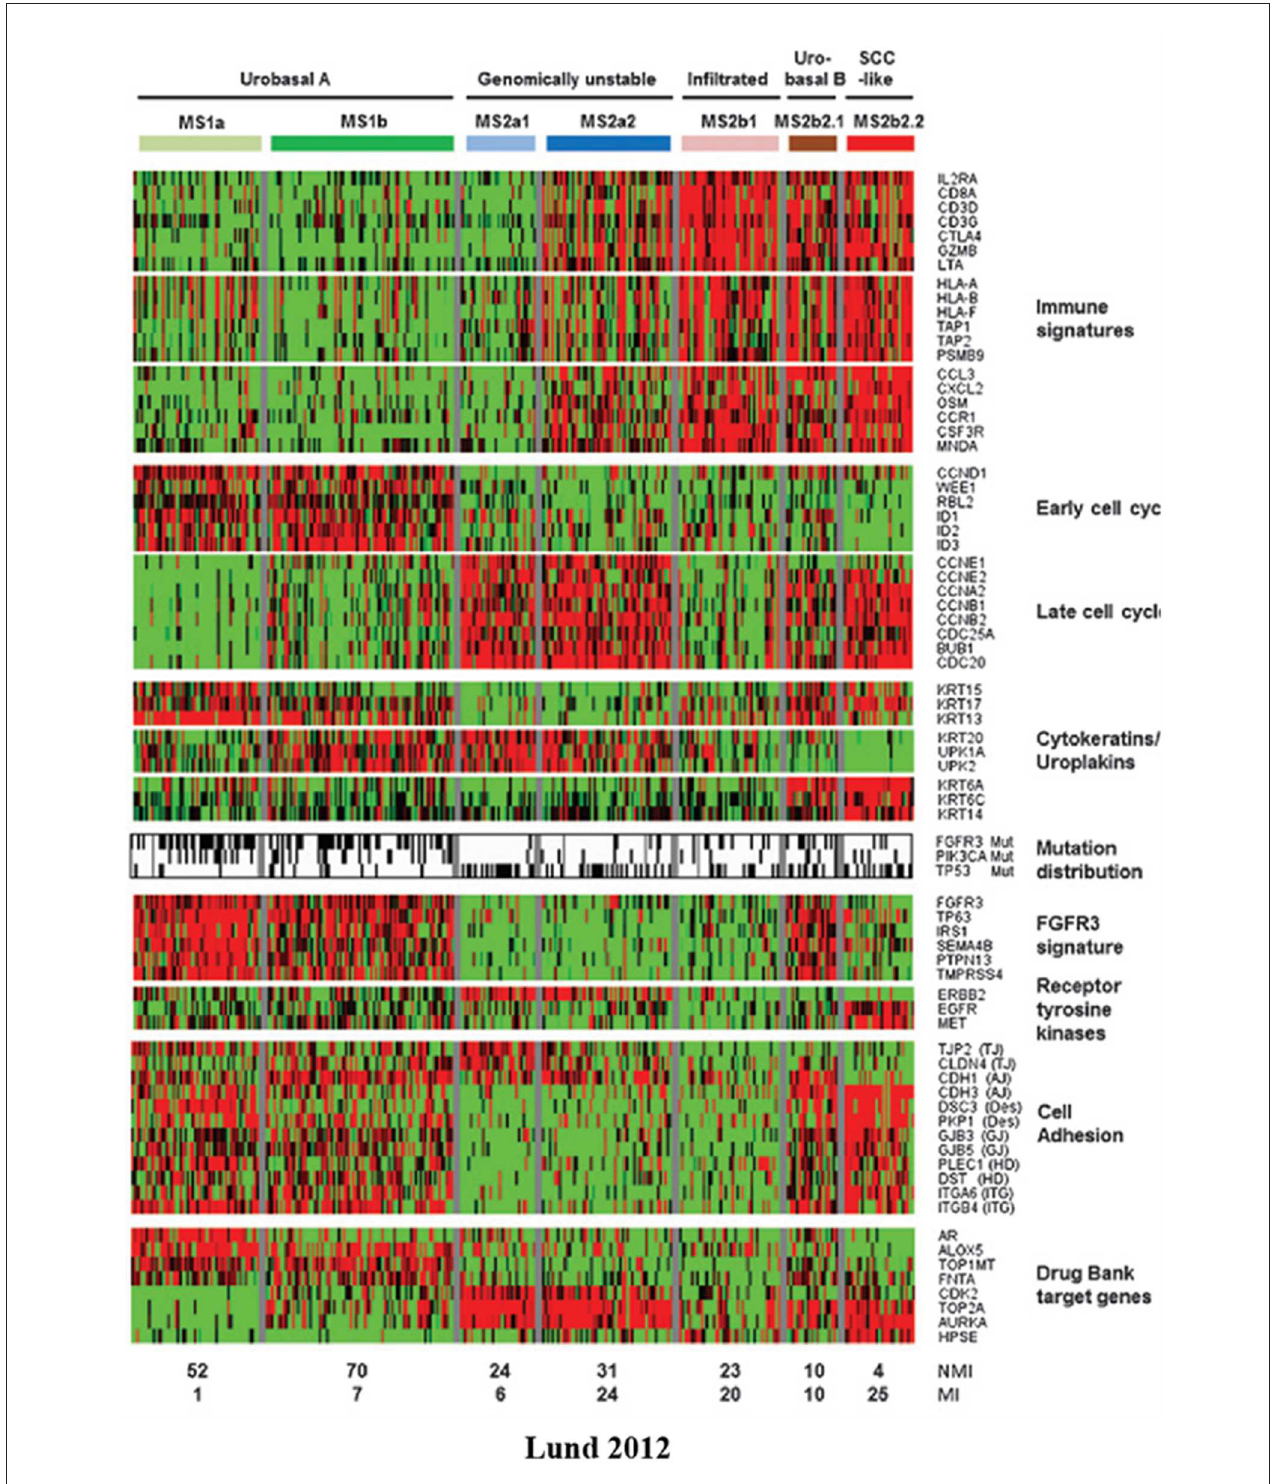
FIGURE 2 | Heatmap of mRNA-seq data from the Lun 2012 molecular subtyping system. BCs are divided into five subtypes according to their genetic expression profiles (32). Red, high expression; green, low expression; black; mutation; white, wild-type; gray, no mutation data. SSC, squamous cell carcinoma; FGFR3, fibroblast growth factor receptor